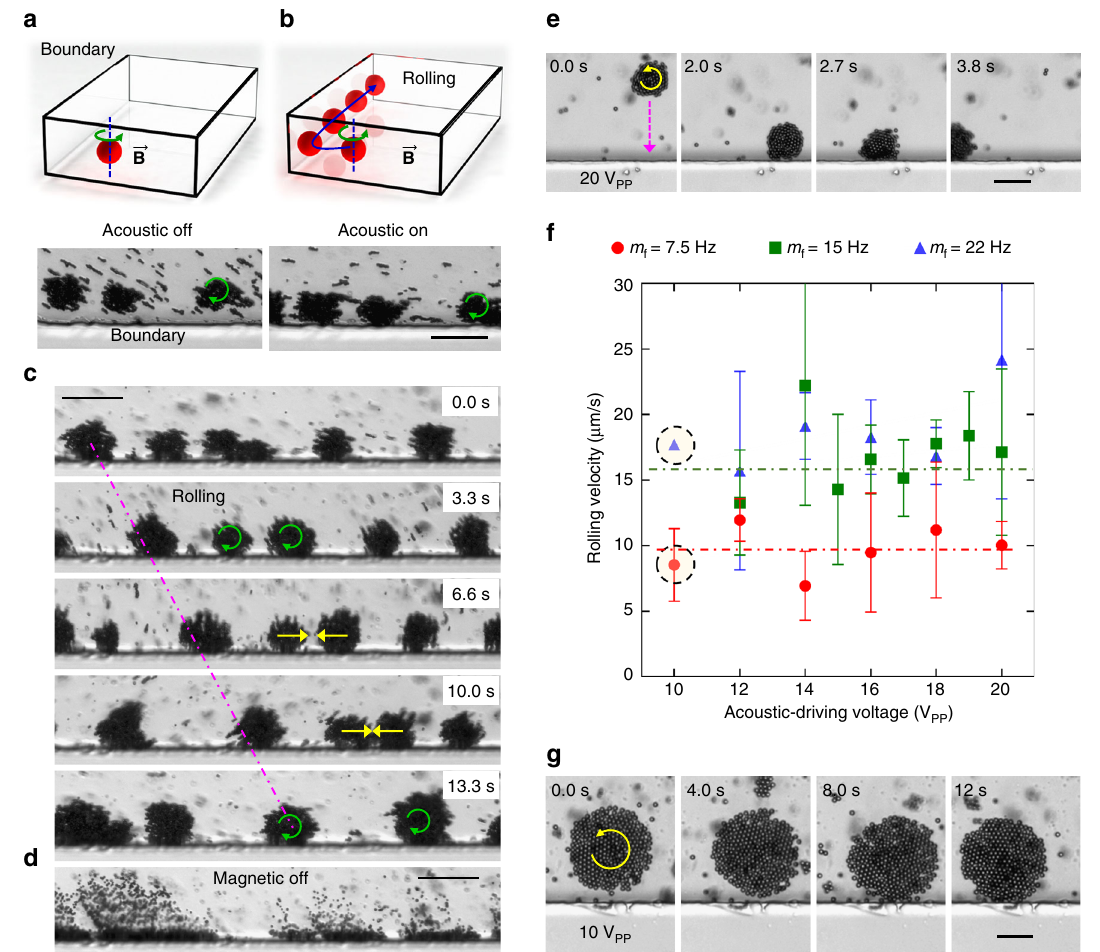
Fig. 5 Rolling motion in acoustic and magnetic fi elds. a The 1 – 2 µ m superparamagnetic particles self-assemble and form spinning aggregates rotating in the clockwise direction in the presence of a magnetic fi eld. b The aggregate migrates towards the channel wall due to the radiation force of an acoustic fi eld. c Image sequence demonstrates the rolling-type propulsion along the sidewall of the micro fl uidic channel (Supplementary Movie 4). d The superparamagnetic particles disassociate as soon as the magnetic fi eld is turned off. Scale bar of b – d is 50 µ m. e Image sequence demonstrates the counter-clockwise motion of an aggregate and executing rolling when reached the wall under a magnetic fi eld strength and rotation frequency of 20 mT and 20 Hz, respectively, at an acoustic driving voltage of 20 V PP (Supplementary Movie 6). Scale bar , 25 µ m. f The plot of the rolling velocity against acoustic driving voltage at magnetic rotational frequencies ( m f ) of 7.5, 15 and 22 Hz, respectively, at 15 mT, of 2.9 µ m superparamagnetic particles. Each data point represents the average rolling velocity analysed from 3 – 5 swimmers except data points at 10 V PP . The error bar represents the standard deviation (s.d.). g An aggregate is shown weak to no rolling at low-acoustic driving voltages of 10 V PP under a magnetic fi eld strength and rotation frequency of 15 mT and 7.5 Hz, respectively (Supplementary Movie 7). Scale bar , 25 µ